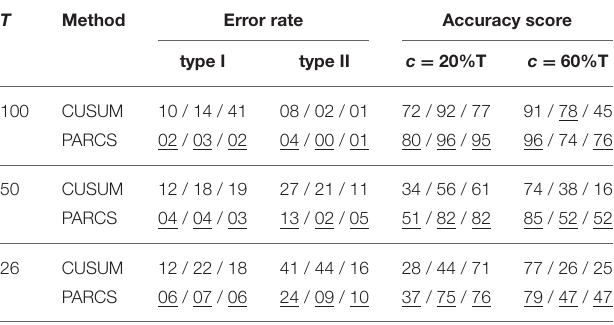
TABLE 2 | Comparing PARCS to CUSUM with binary segmentation for multiple CP detection for different lengths of the time series; error rates and accuracy scores are rounded; triplet, scenarios 1 / 2 / 3; underline, method with lower error rate or higher accuracy score; nominal α levels, 0.05 and 0.30 for CUSUM and PARCS,